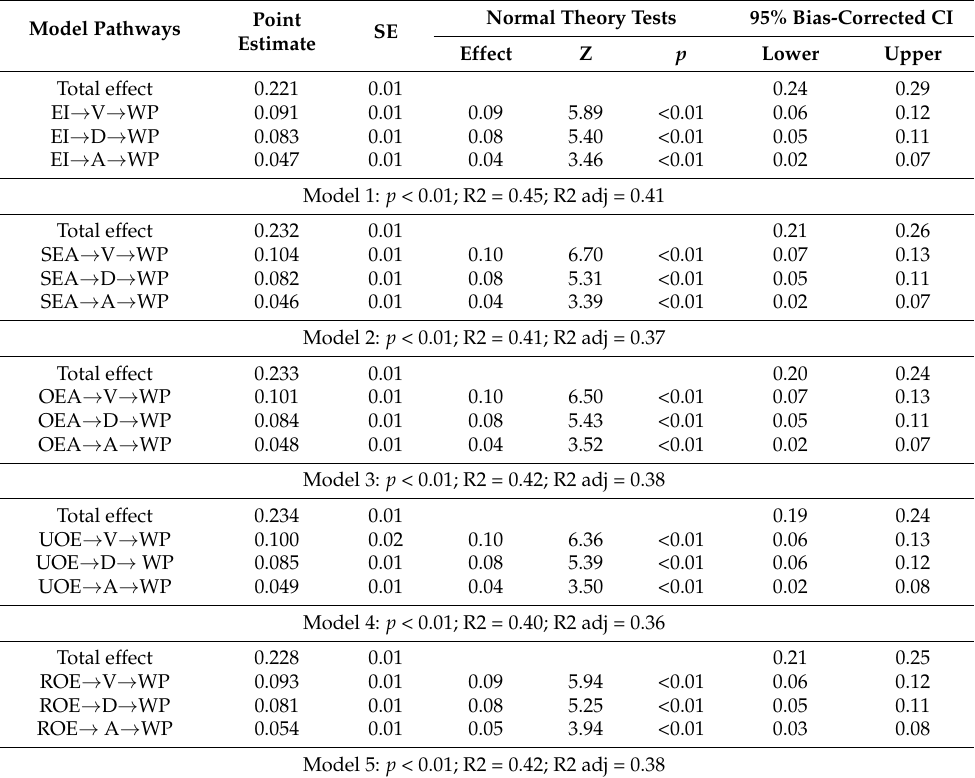
Table 2. Multiple Mediating Analyses Testing the Mediating Effect of Engagement